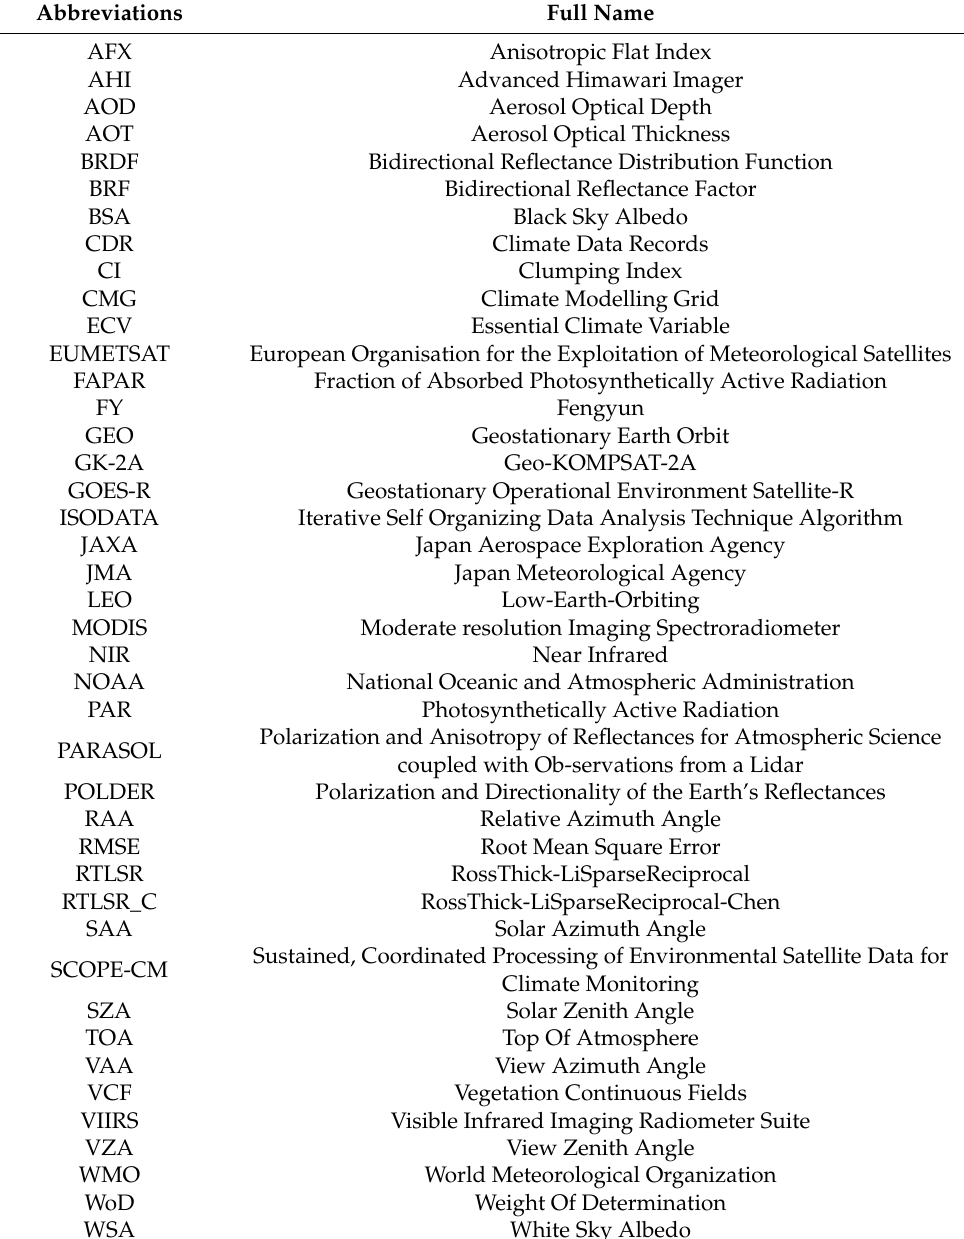
Table A1. Lists of abbreviations used in this